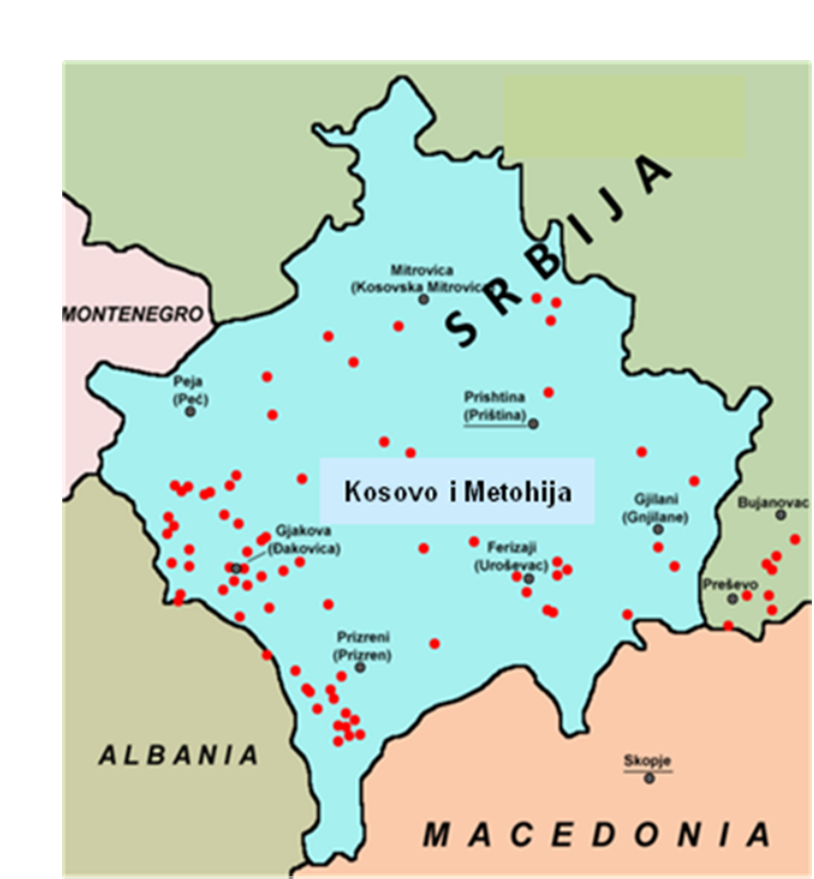
Figure 5 – Sites in Kosovo and southern Central Serbia where NATO aviation used forbidden munition with depleted uranium during the 1999 bombing Рис . 5 – Дислокации в Косово и юге Центральной Сербии , где воздушные силы НАТО использовали запрещенные боеприпасы с обедненным ураном во время бомбардировок 1999 г